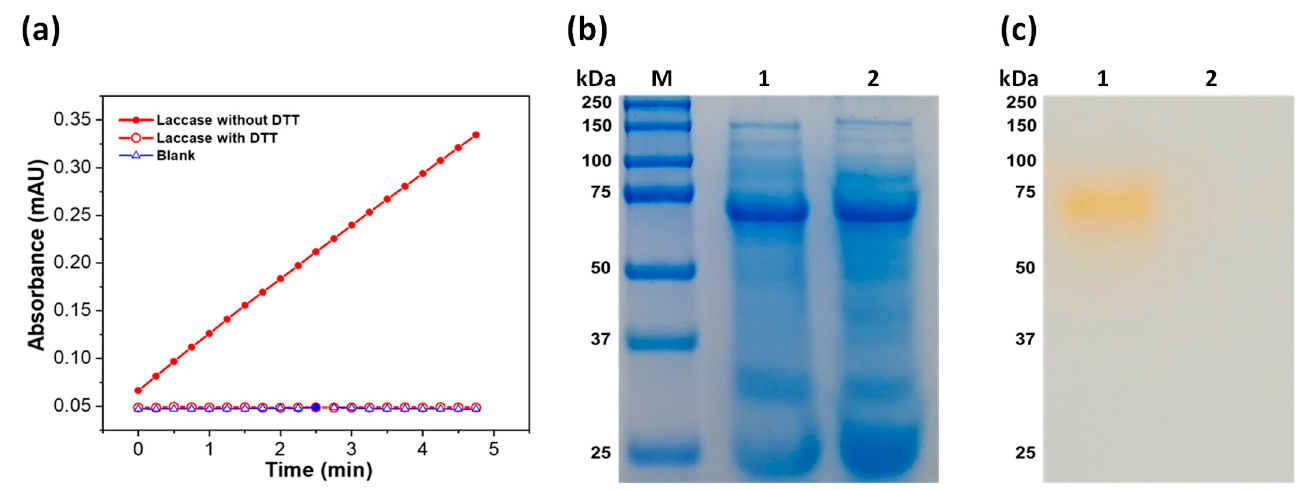
Figure 7. Effect of DTT on the enzymatic activity of laccase from A. pediades . ( a ) The catalytic activity of laccase in the presence and absence of DTT. ( b ) 12%-SDS–PAGE of laccase in the presence (lane 2) and absence of DTT (lane 1). The laccase protein was incubated with DTT (15 mM) for 5 min. ( c ) Zymogram of laccase with (lane 2) and without DTT (lane 1). In each lane, 20 μ g of laccase protein was loaded. Zymography was carried out using 2,6-DMP (2 mM) as a substrate.